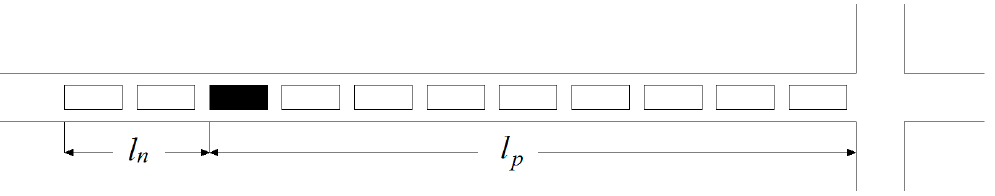
Figure 2. Schematic diagram of one connected vehicle.